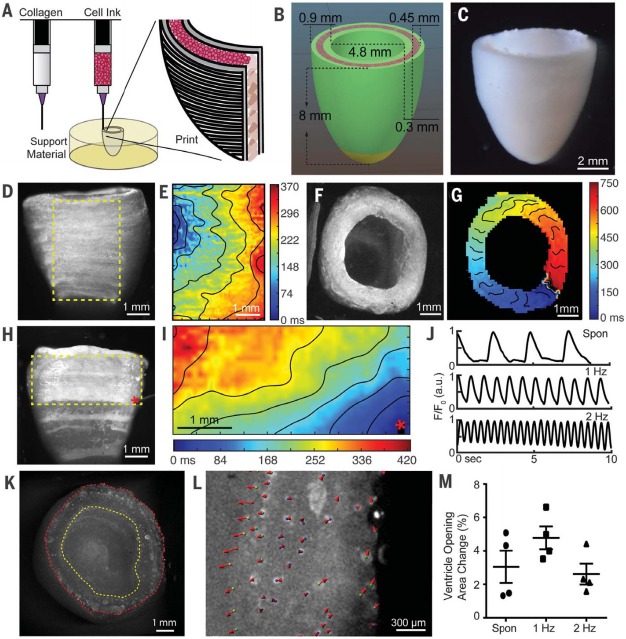
Figure 1. 3D printing of human hearts. ( A ) Schematic of dual-material FRESH printing. ( B ) Ventricle model with cardiac cells (pink) and collagen shells (green and yellow). ( C ). Micrograph of FRESH-printed ventricle. ( D ) FRESH-printed ventricle stained with calcium-sensitive dye show- ing homogeneous cell distribution. ( E ) Calcium mapping showing calcium wave propagation of the boxed segment (yellow) of ( D ). ( F ) Top view of FRESH-printed ventricle stained with calcium- sensitive dye. ( G ) Calcium mapping showing circular calcium wave propagation around the ventricle. ( H ) Point stimulation of FRESH-printed ventricle stained with calcium-sensitive dye (red asterisk in- dicates electrode location). ( I ) Calcium mapping of the subregion (yellow) in ( H ) showing anisotropic calcium wave propagation with longitudinal conduction velocity. ( J ) Calcium transient traces during spontaneous contractions (top), 1 Hz field stimulation (middle), and 2 Hz field stimulation (bottom). ( K ) Top-down image of the FRESH-printed ventricle with inner (yellow) and outer (red) walls out- lined. ( L ) Subregion of the ventricular wall analyzed for displacement during 1 Hz field stimulation, showing inner and outer wall motion upon stimulation. Magnitude and direction are indicated using arrows. ( M ) Cross-sectional area changes of the ventricle interior chamber at peak systole ( N = 4, data means are ± SD). Reproduced with permission from [61], the American Association for the Advancement of Science